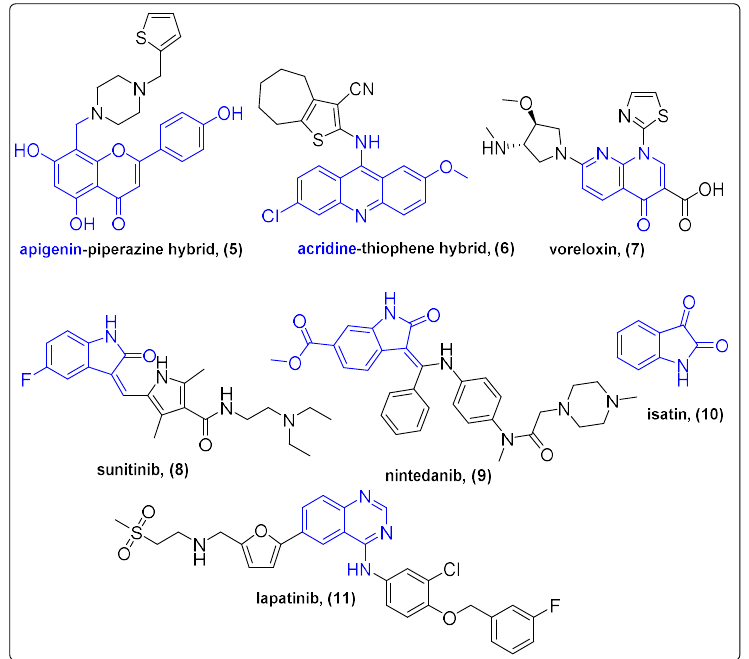
Figure 3. Natural products and their hybrids with heterocyclic moieties.